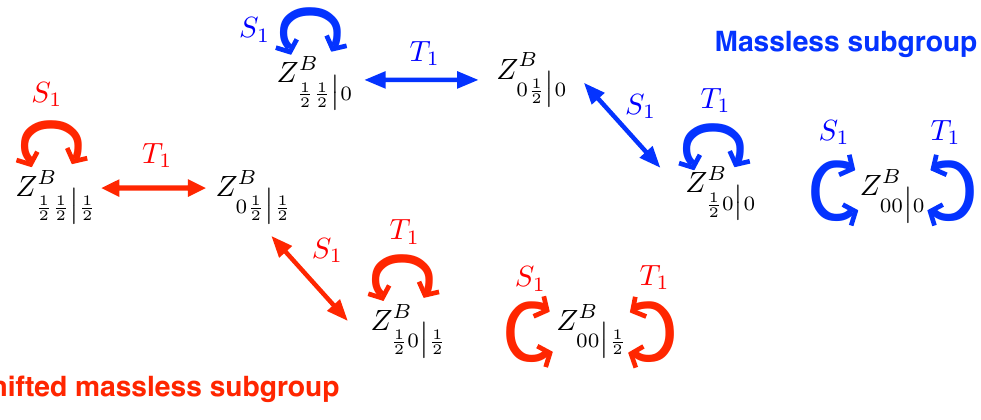
Figure 11 . Action of the two-dimensional modular group over of the eight bosonic partition functions Z B dimensionally reduced to the ( x 0 ; x 1 ) (cid:11) 0 (cid:11) 1 j (cid:11) 2